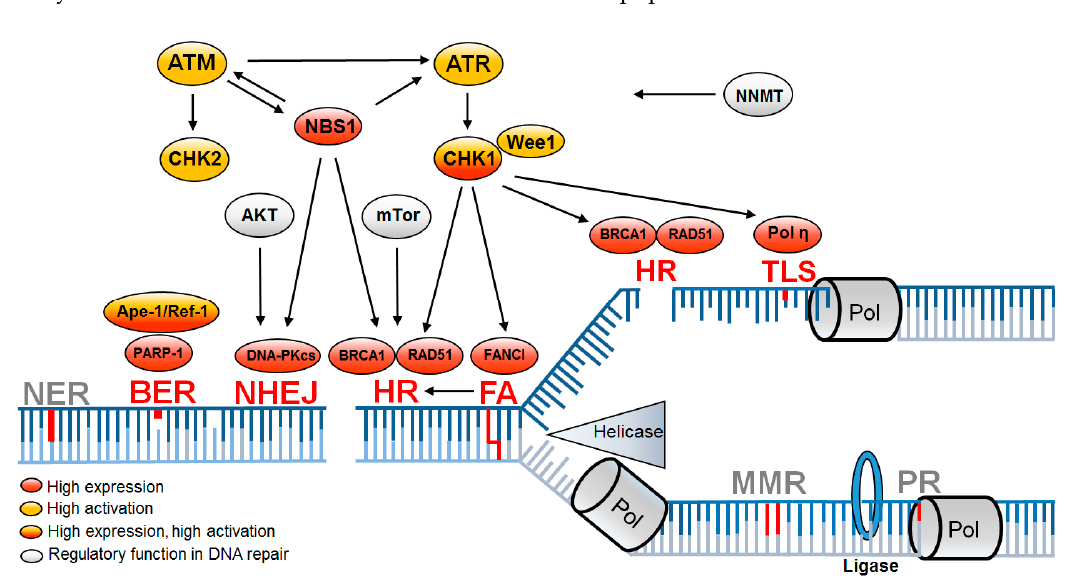
Figure 2. DNA repair pathways altered in CSCs are associated with DNA replication. Replication- associated DNA repair pathways leading to enhanced DNA repair (red) mediate resistance in CSCs, while further replication-associated DNA repair pathways remain unchanged (gray). Upregulation is based on increased expression (red) or increased activation (yellow) or both (red/yellow) and is supported by regulatory proteins (gray). BER—base excision repair; FA—Fanconi anemia; HR— homologous recombination; NER—nucleotide excision repair; NHEJ—non-homologous end joining;